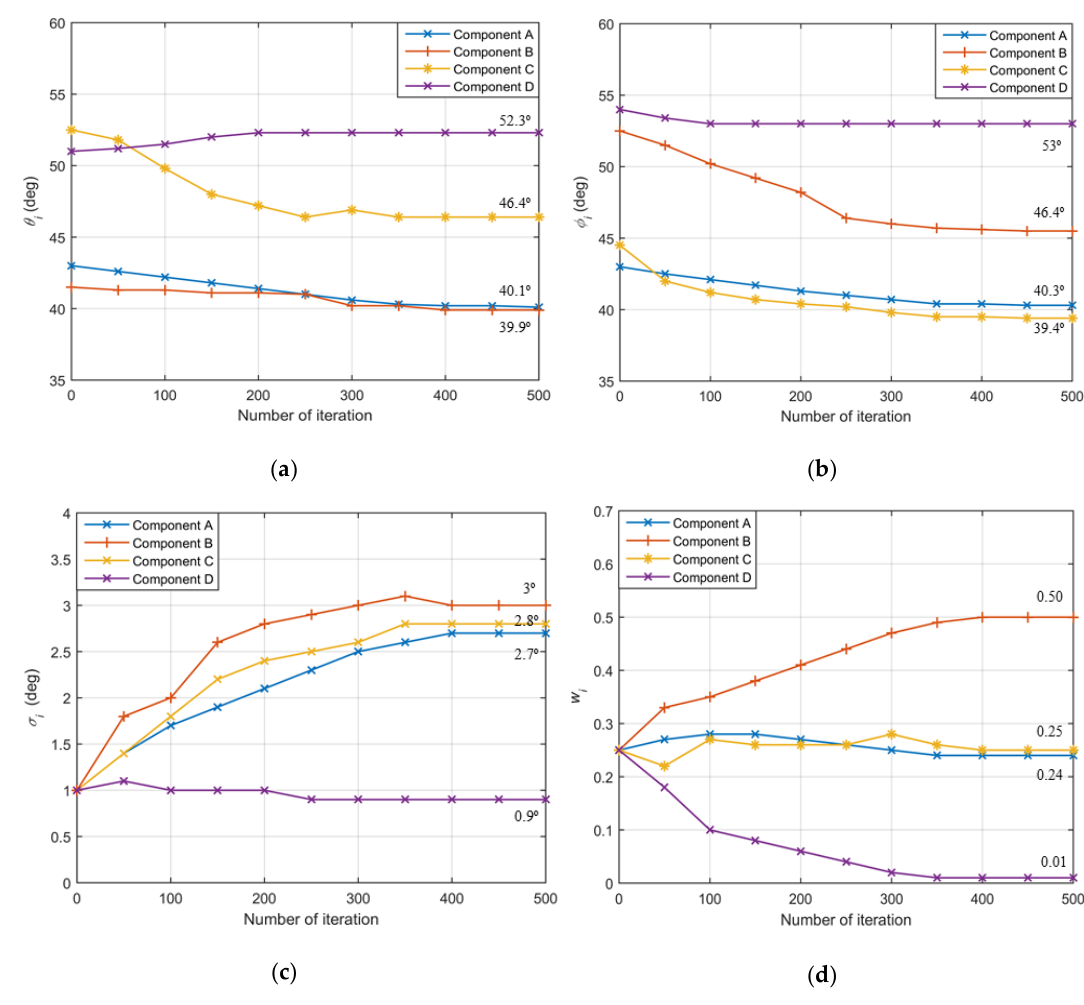
Figure 3. ( a ) The variety process of nominal azimuths in EM iterations; ( b ) the variety process of nominal elevations in EM iterations; ( c ) the variety process of angular spreads in EM iterations; ( d ) the variety process of weights in EM iterations.